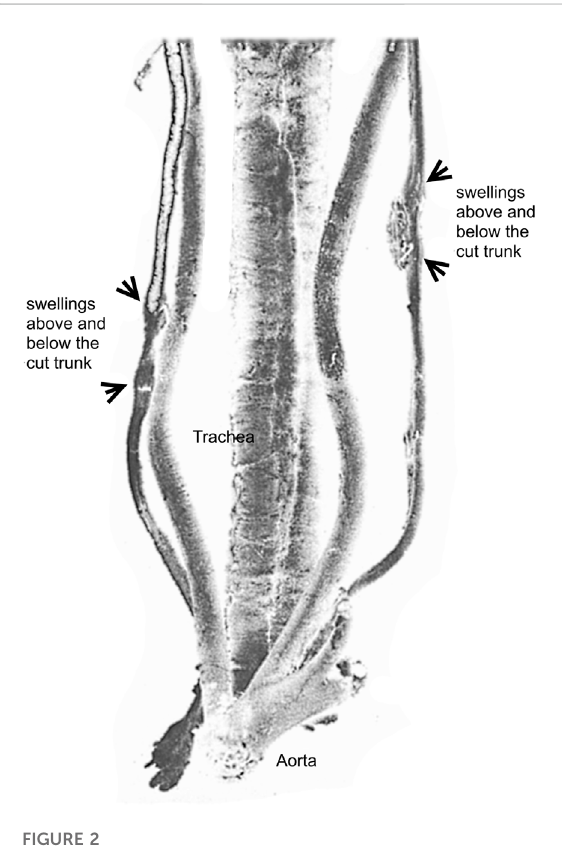
FIGURE 2 Thepreparationofanervesuturefollowedbyregenerationin a dog by Cruikshank at the Hunter ’ s museum. Adapted from Ochs, 1977. Illustrated from a posterior view, the preparation shows the aorta, the trachea, the right vagus nerve and the left vagus nerve both reunited after section by